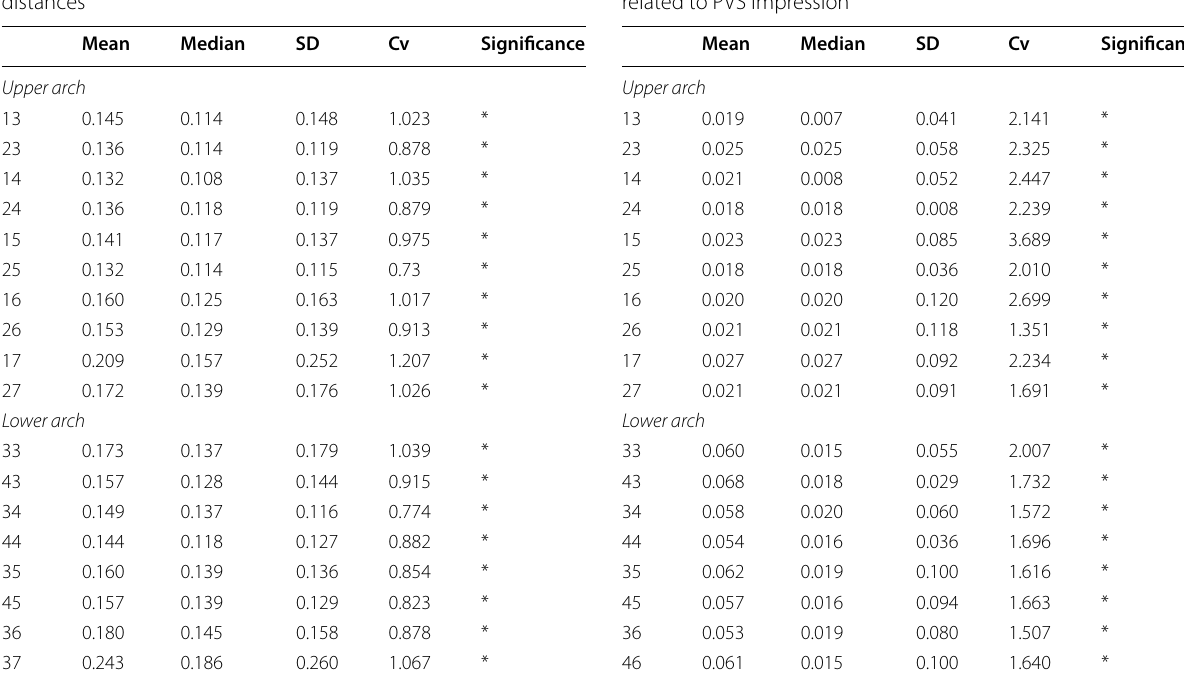
Table 3 Repeatability of linear measurements (mm) of STL